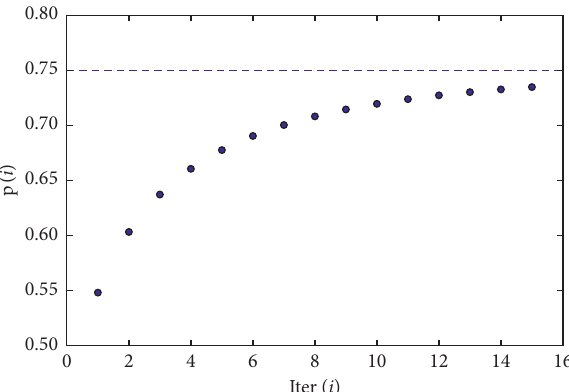
Figure 2: The diagram of the relationship between iteration number and position